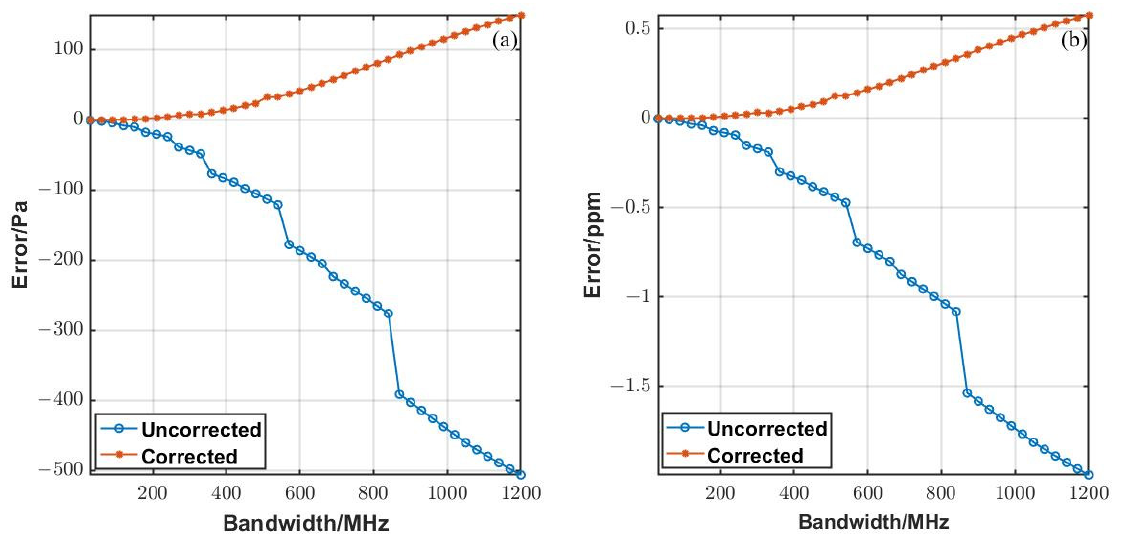
Figure 4. ( a ) Pressure error at different filter-bandwidths. ( b ) Equivalent XCO 2 error at different filter-bandwidths.